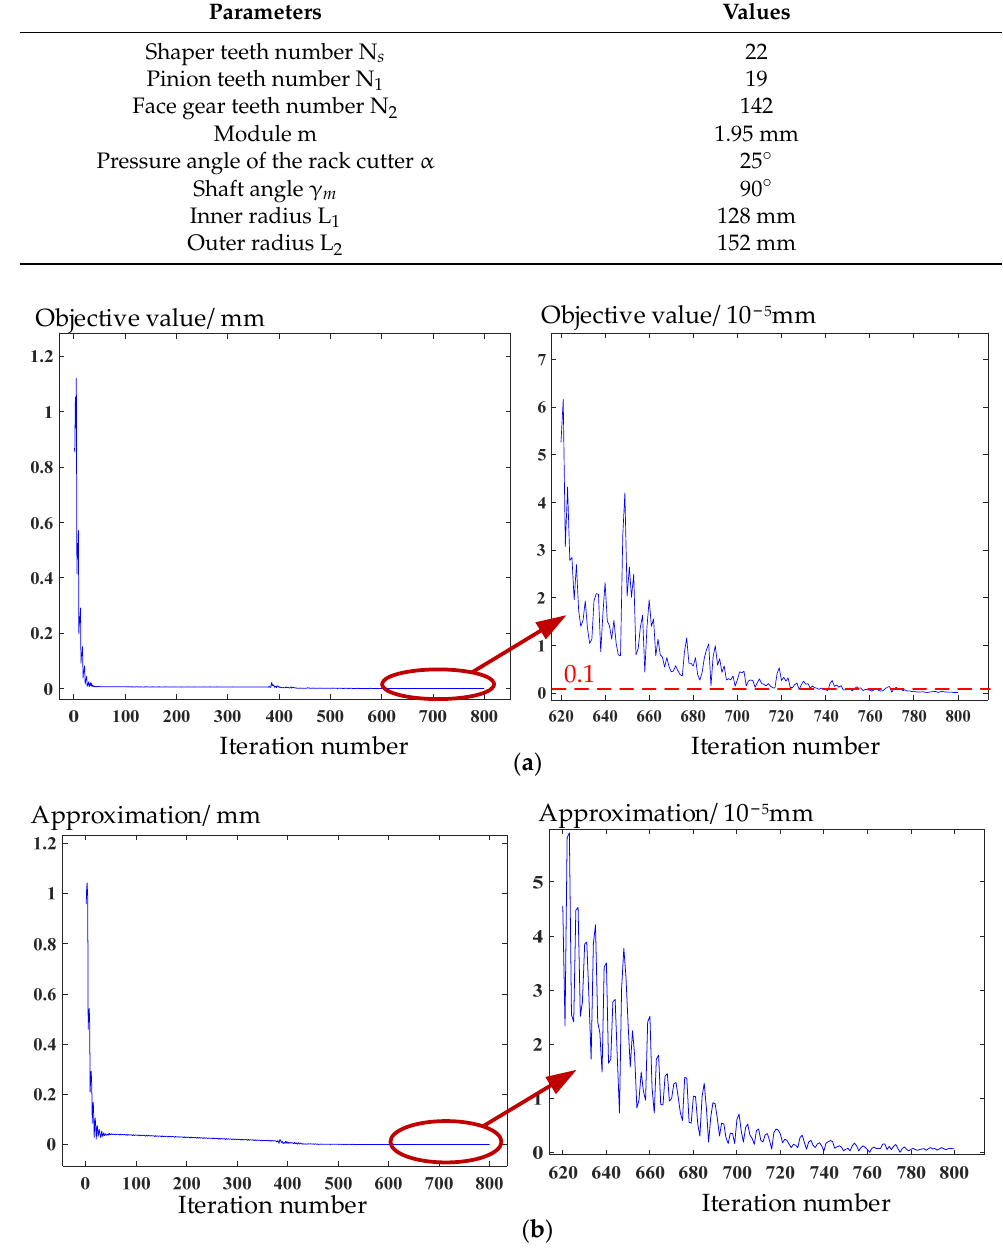
Figure 7. Convergence curves of ( a ) objective value and ( b ) iterative solution in the second stage of the algorithm.